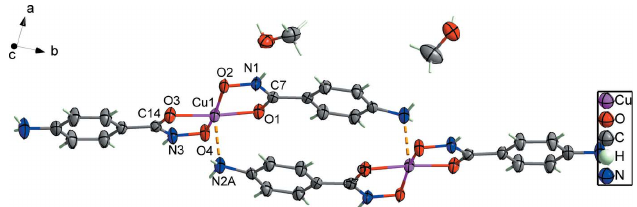
Figure 1 The structure of title complex, with displacement ellipsoids drawn at the 30% probability level. Two complexes are represented, in order to emphasize contacts involving the NH 2 group in the ligand (dashed bonds). [Symmetry code: (A) (cid:3) x , 1 (cid:3) y , 1 (cid:3) z